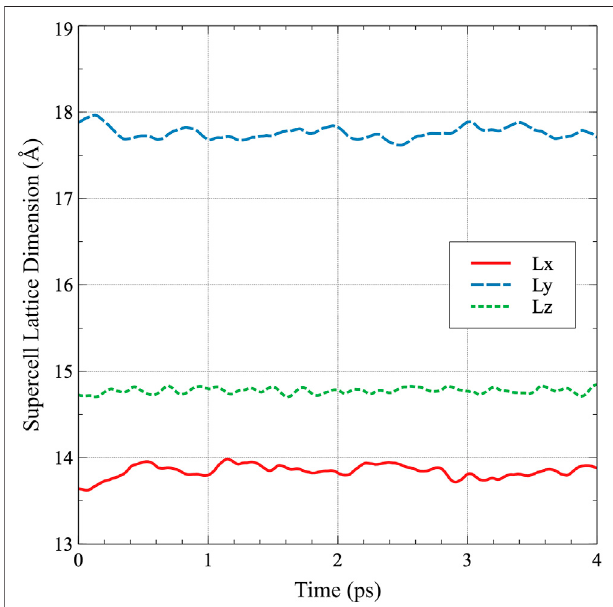
FIGURE1| Thesupercelllatticedimensionsasafunctionoftimefor α -U. Each dimension is averaged over the fi nal 3 ps to obtain the average lattice constant in the simulation.